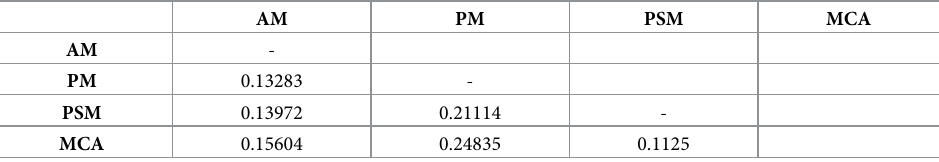
Table 1. Weir and Cockerham unweighted pairwise F ST